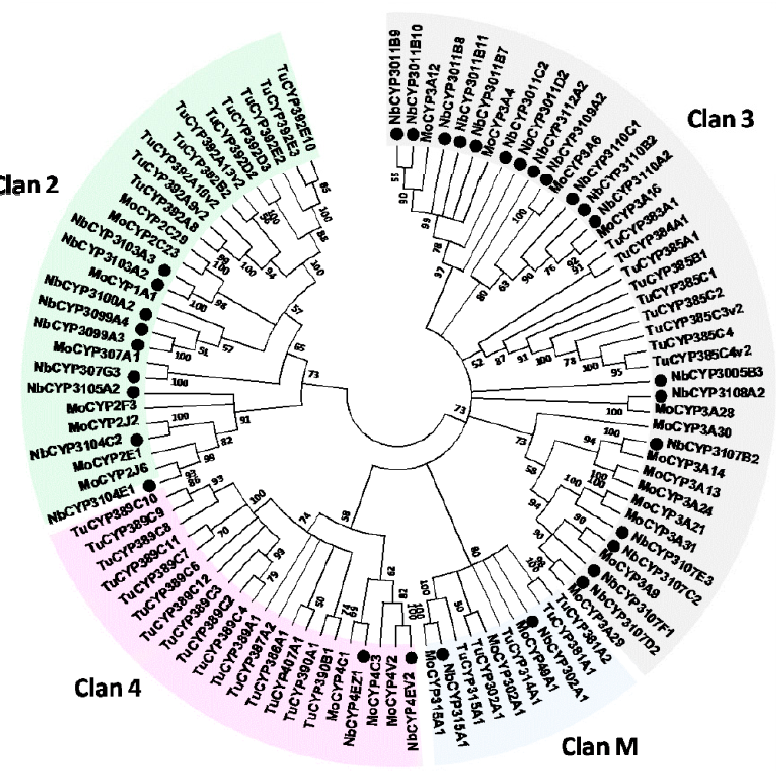
Figure 2. Neighbor-joining phylogenetic analysis of the N. barkeri P450 genes. Dots represent the N. barkeri P450 protein sequences. Nb: N . barkeri ; Mo: M. occidentalis ; Tu: T. urticae .